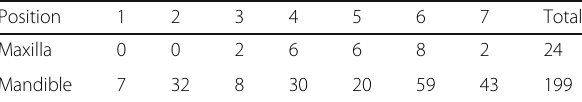
Table 2 Distribution of implants in situ ( n = 223)